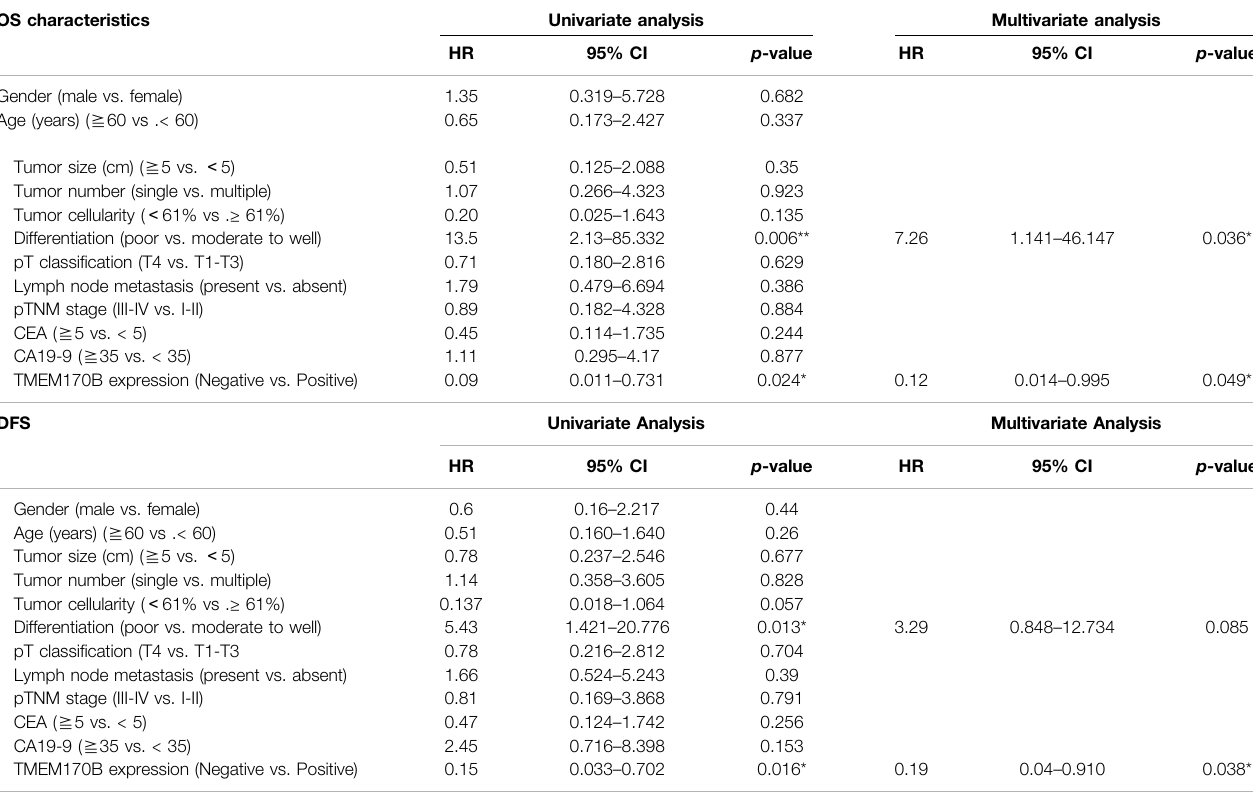
TABLE 2 | Univariate and multivariate Cox analyses of clinicopathological factors and clinical outcomes. OS characteristics Univariate